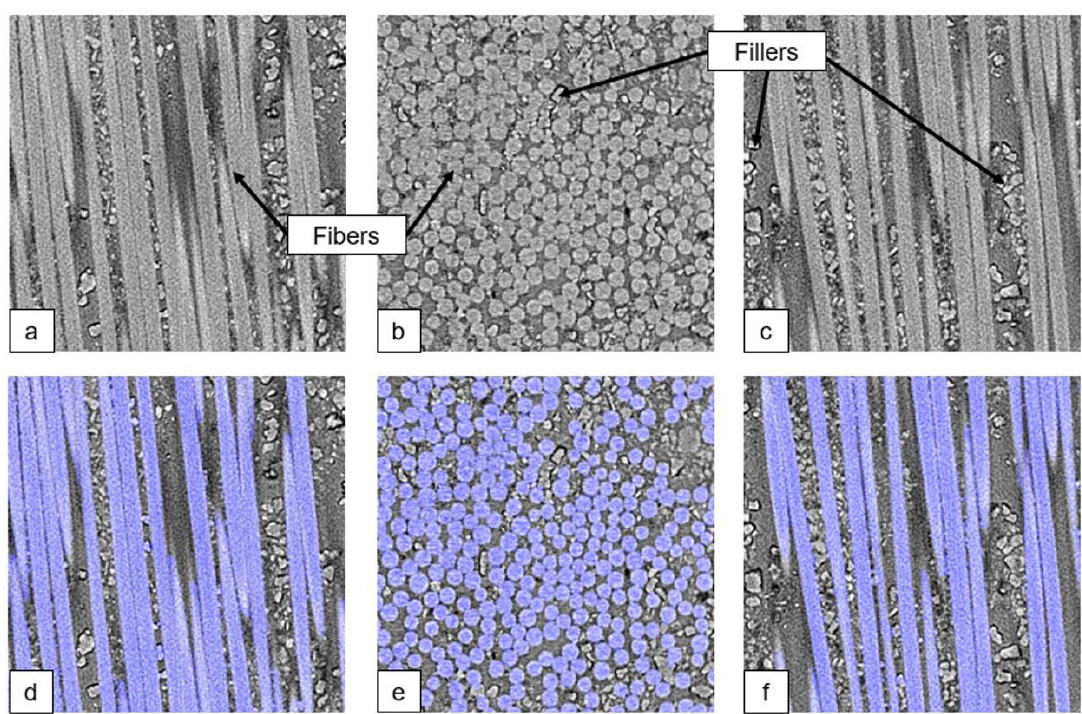
Figure 11. Slices of Tomo 2 and their respective segmentations: (a), (b) and (c) original images; (d), (e) and (f) the respective segmentations of fibers without considering the